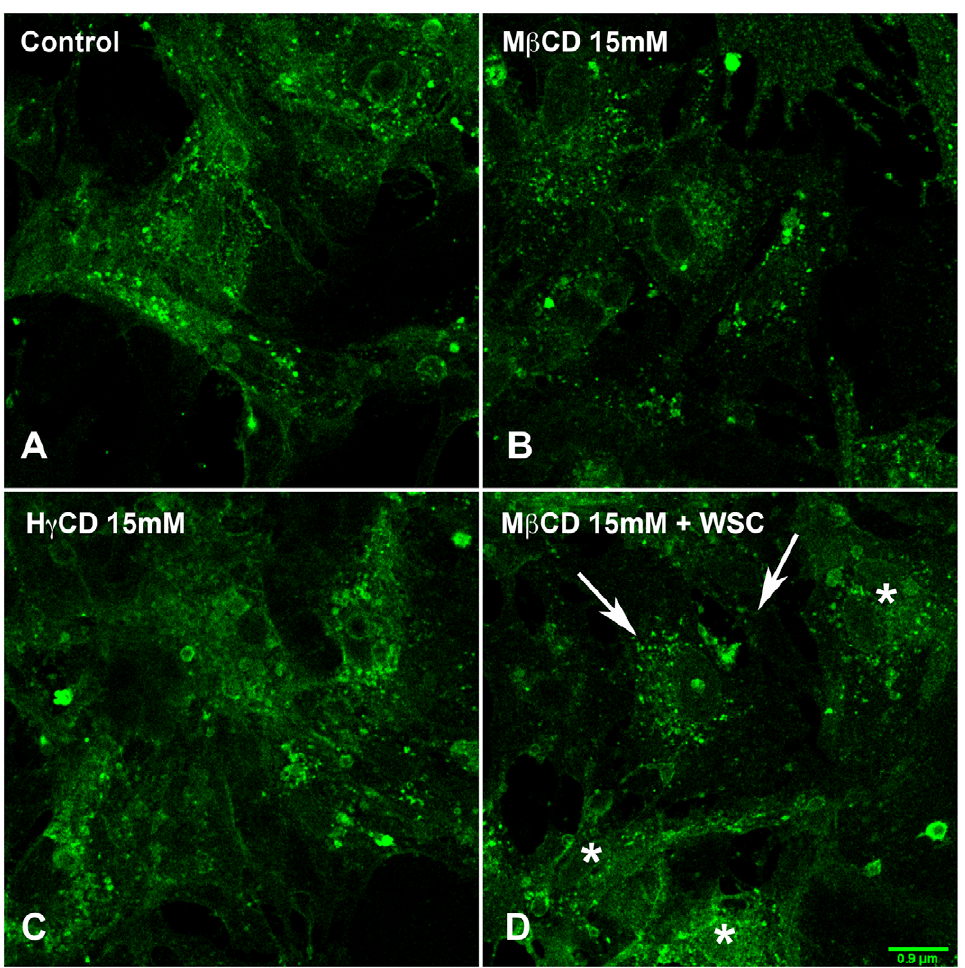
Figure 3. Treatment with M b CD leads to changes in membrane raft organization of cardiomyocytes. Confocal images of control (A) and cardiomyocytes pre-treated with 10 mM M b CD (B) or H c CD (C). Cells were washed, fixed and then labeled with CTXb-Alexa 488, which recognizes GM1, a raft marker. In comparison to control cells, which show a homogenous strong labeling for GM1, cholesterol-depleted cardiomyocytes reveals a more discrete labeling. Cells treated with H c CD show GM1 labeling similar to control cells whereas cholesterol-replenished cells (D) exhibit both patterns of cholesterol-depleted (arrows) as well as control (asterisks) GM1 labeling. Scale bar: 0.9 m m.